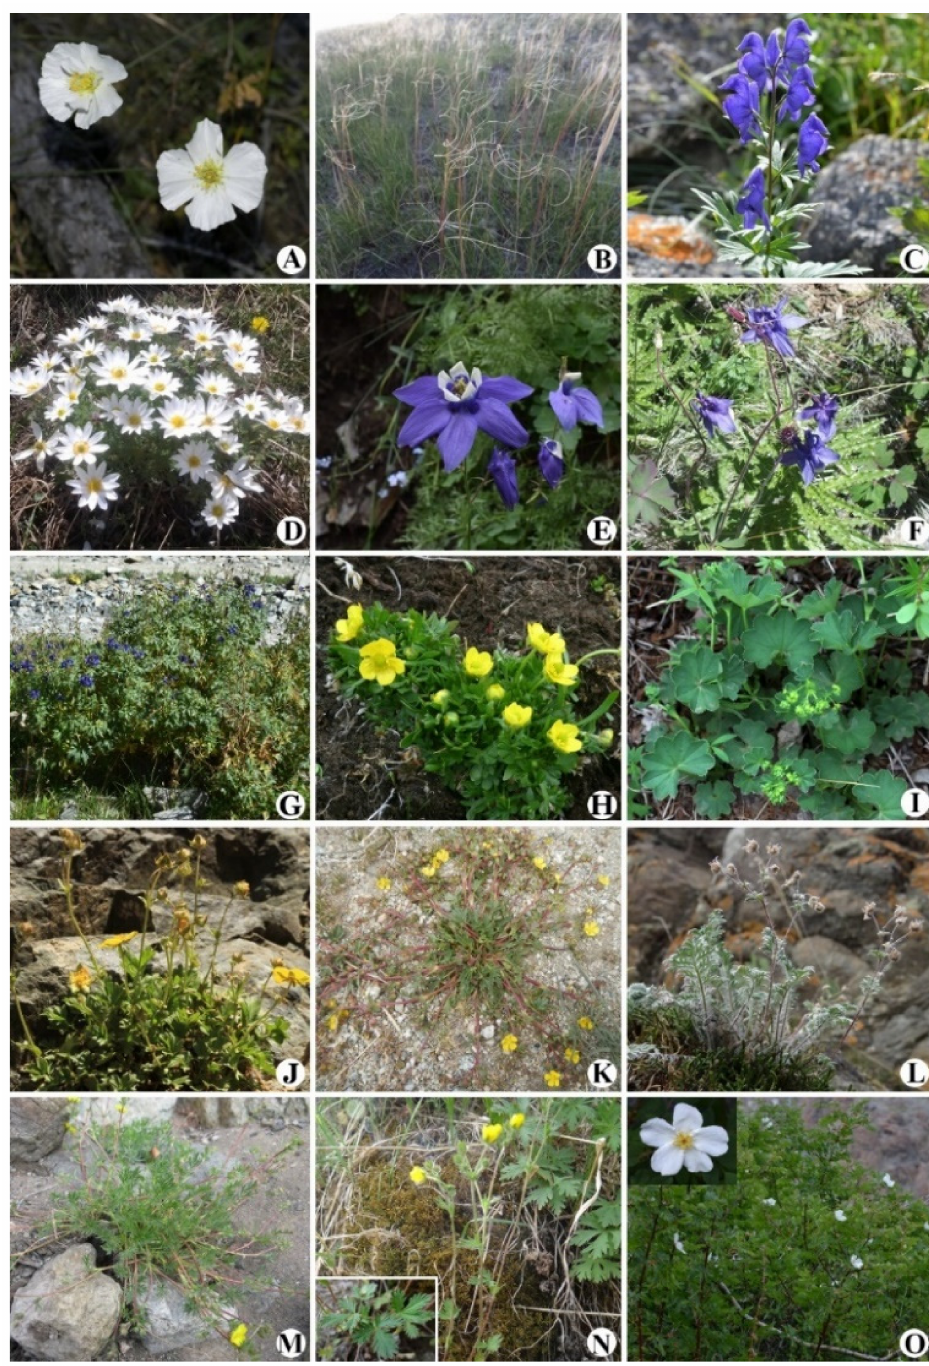
Figure A2. Representative taxa of the endemic vascular plants of Mongolia. ( A ) Papaver baitagense ; ( B ) Stipa khovdensis ; ( C ) Aconitum gubanovii ; ( D ) Adonis mongolica ; ( E ) Aquilegia daingolica ; ( F ) Aquilegia grubovii ; ( G ) Delphinium changaicum ; ( H ) Ranunculus sapozhnikovii ; ( I ) Alchemilla changaica ; ( J ) Potentilla ikonnikovii ; ( K ) Potentilla laevipes ; ( L ) Potentilla mongolica ; ( M ) Potentilla schmakovii ; ( N ) Potentilla x vanzhilii ; ( O ) Rosa baitagensis . Photos: ( A , C , E , F , G , O ) by S.Baasanmunkh; ( B , L , N ) by V. Gundegmaa; ( D ) by M.Urgamal; ( H ) by A.Pyak; ( I , J ) by B.Oyuntsetseg; and ( K , M ) by